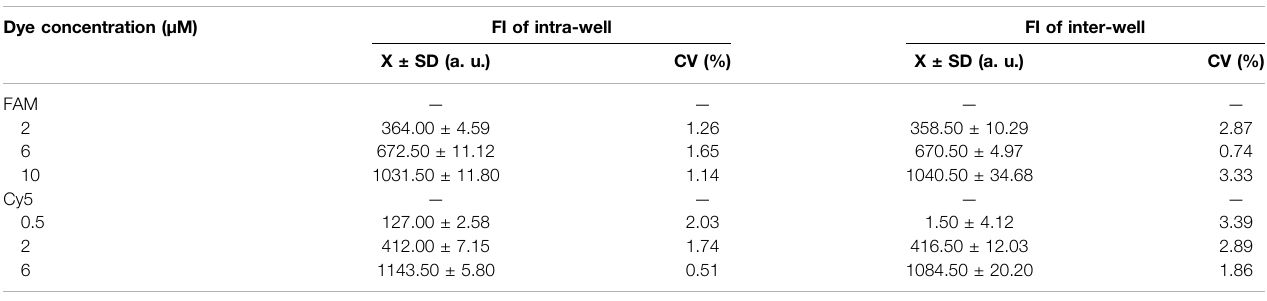
TABLE 1 | Intra-well repeatability and inter-well precision of the FI. Dye concentration ( μ M)